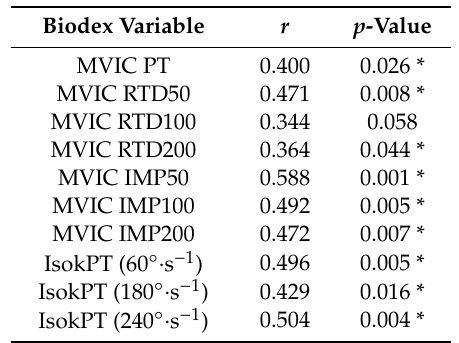
Table 2. Associations between Biodex dynamometer arm length setting and unilateral isometric and isokinetic knee extension performance